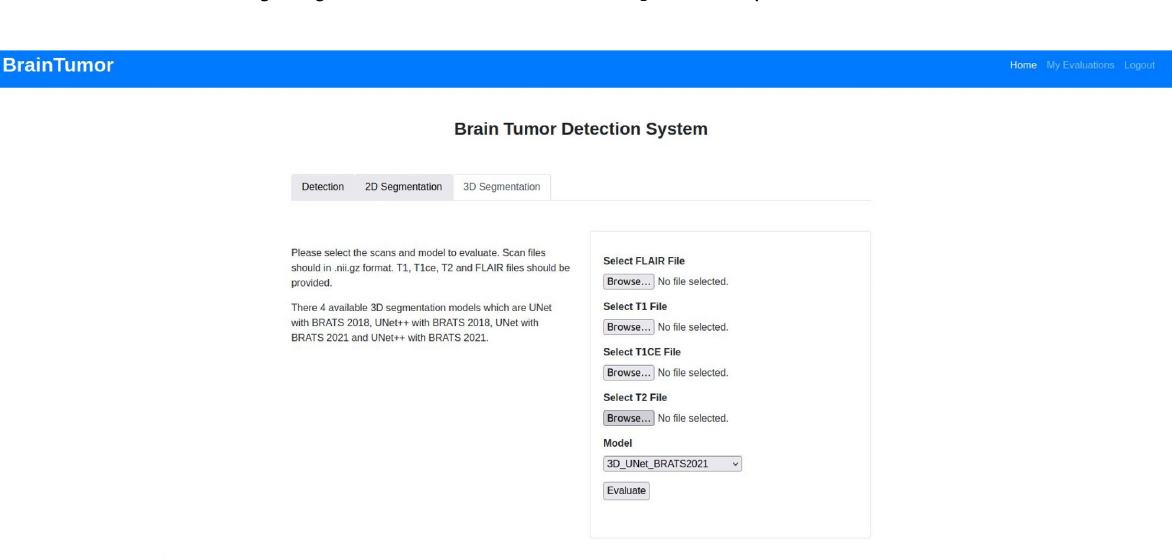
prediction of the brain tumor segmentation models. The bar plot represents the performance differences between the 2D and the 3D models which varied between 14% to 16% showing the 3D models performed better. Another interesting observation on the U-Net and U-Net+ + model performances was the similarity between them. Although the U-Net model performed better than the U-Net++ in both 2D and 3D images, the difference was only less than 2%. The resulting differences between the 2D DNNs and 3D DNNs can be caused by the differ- ences in the 2D and 3D datasets. The 2D dataset contains 3064 t1-weighted 2D MRIs combin- ing images of three different anatomical planes. They also have different intensities for tumor